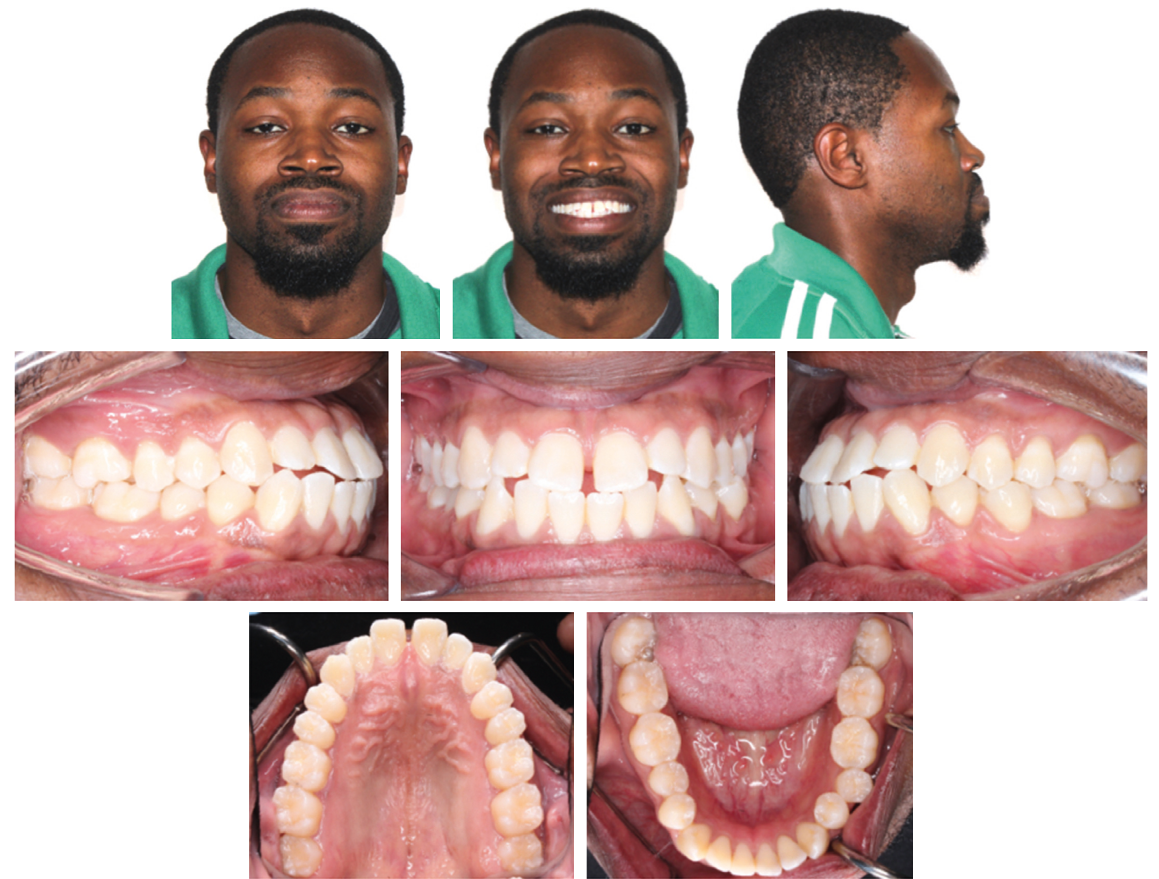
Figure 1: Pretreatment facial and intraoral